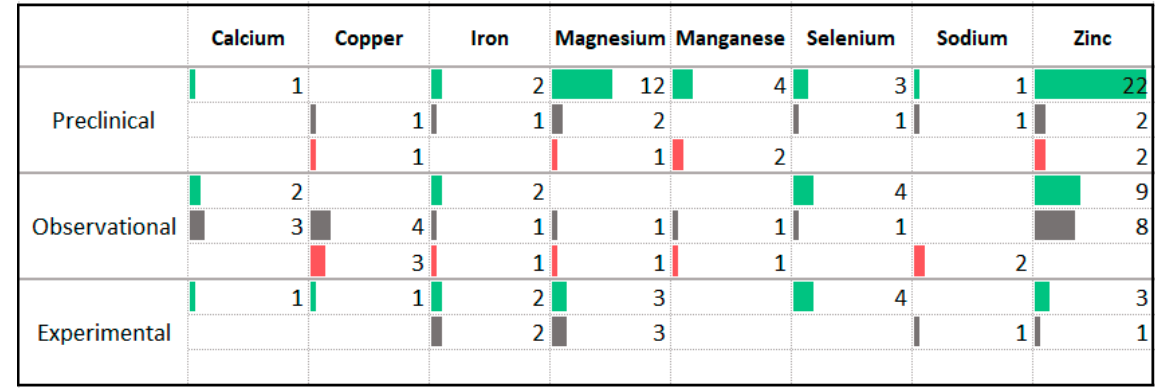
Figure 11. Studies assessing minerals and anxiety. █ Higher intake or levels associated with decreased anxiety. █ No association between intake or levels and anxiety. █ Higher intake or levels associated with increased anxiety.